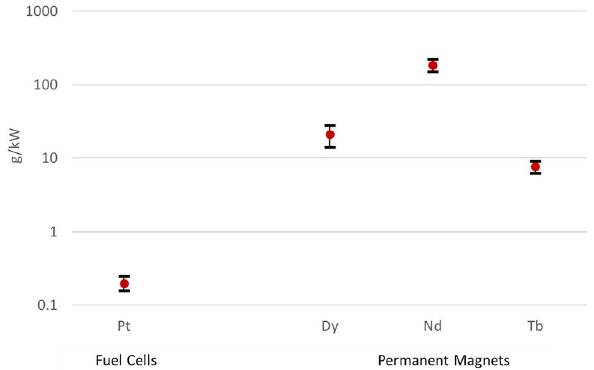
Fig. 2 PEM fuel cell and NdFeB permanent magnet material intensi- ties. Note the log scale on the y axis upon which the material intensi- ties are presented. Sources [15, 28–34, 62, 63]